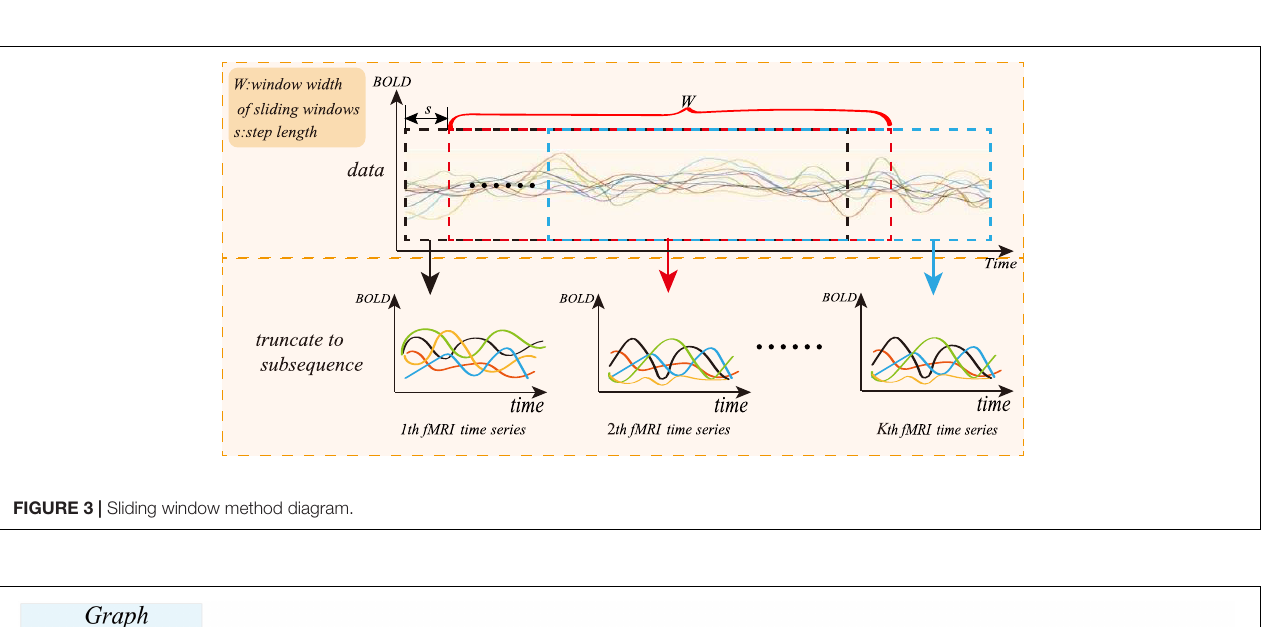
FIGURE 2 | Overall frame diagram, where FCN : functional connectivity networks; Lo − FGN : Low-order functional graph network; Ho − FGN : High − order functional graph network ; A roi represents the adjacency matrix of Lo-FGN; X roi represents the node feature matrix of Lo-FGN, others are the same as above.